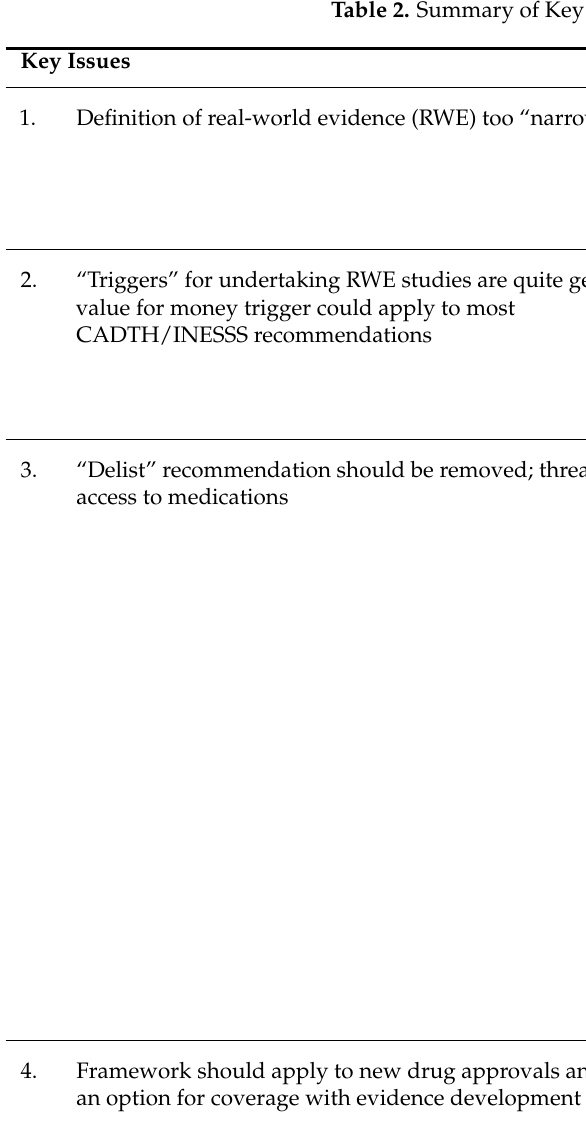
Table 2. Summary of Key